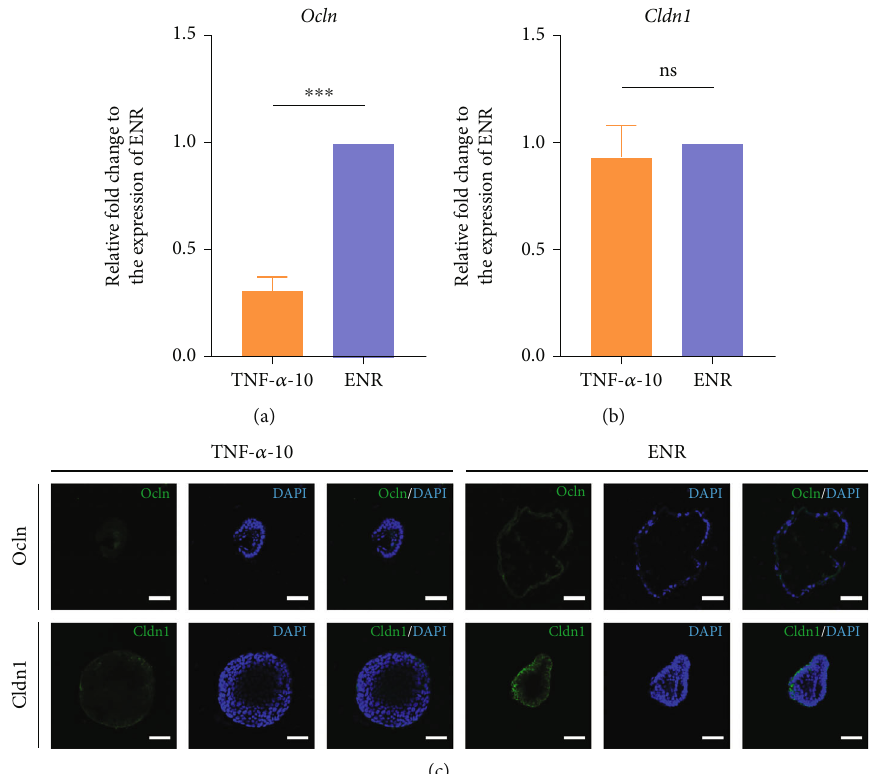
Figure 4: TJP expressions of intestinal organoid with TNF- α treatment. qRT-PCR analyses of Ocln (a) and Cldn1 (b) mRNA in organoids cultured under the indicated conditions ( n = 1 well). P values were determined by two-sided unpaired Student ’ s t -test. Gapdh was used as a control to normalize the expression of target genes. ∗ P < 0 : 05 ; ∗∗ P < 0 : 01 ; ∗∗∗ P < 0 : 001 . (c) Immuno fl uorescence staining of representative TJPs of intestinal organoids, including Ocln ( fi rst row, green) and Cldn1 (second row, green). Scale bars = 50 μ m. The experiments were independently repeated at least three times with similar results. Ocln: occludin; Cldn1: